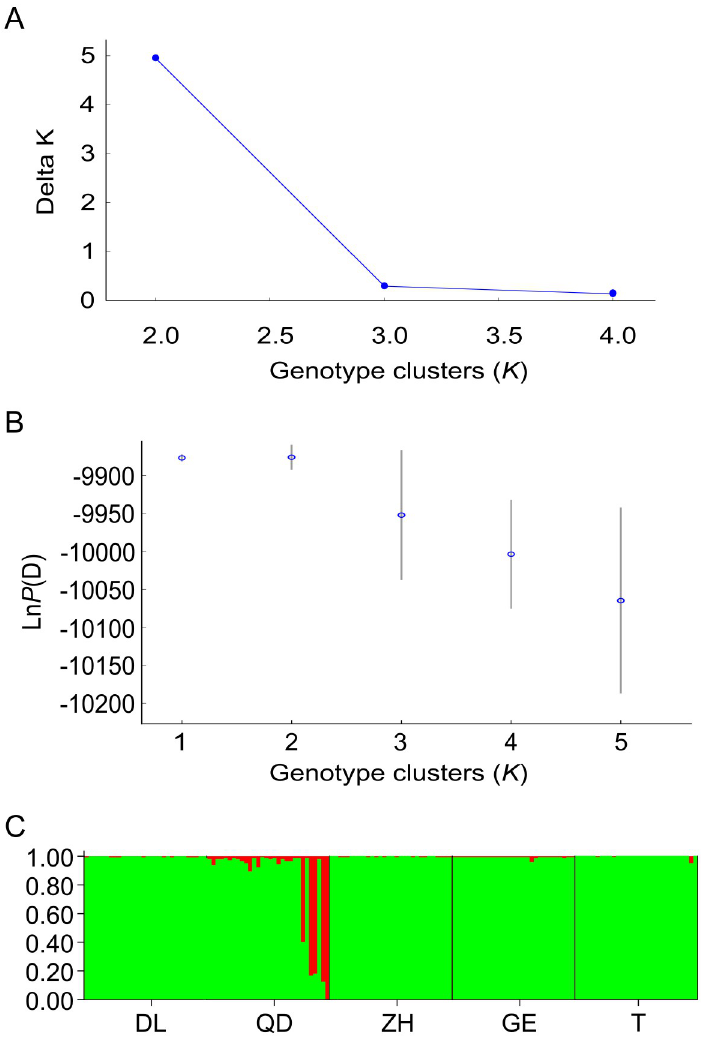
Fig 3. Hierarchical STRUCTURE analysis based on ten microsatellite datasets from 150 T . japonicus collected from five locations along the coasts of the NW Pacific. Δ K (A) and ln P(D) (B) are plotted against the number of genetic clusters (K). The population structure result when K = 2 is shown in (C). Each vertical colored line represents the assignment proportion of membership of each sample and categorized by locations.